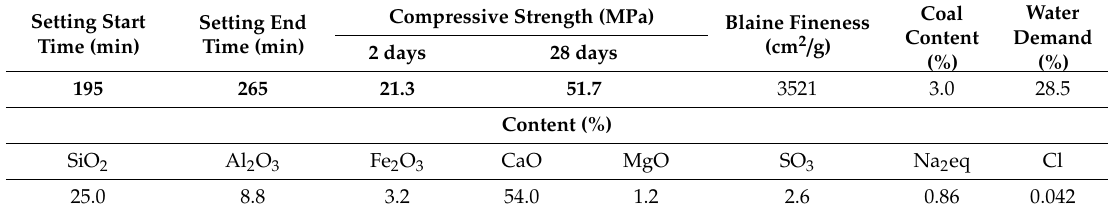
Table 1. Chemical content and physical properties of the cement CEM II / A-V 42.5 N.